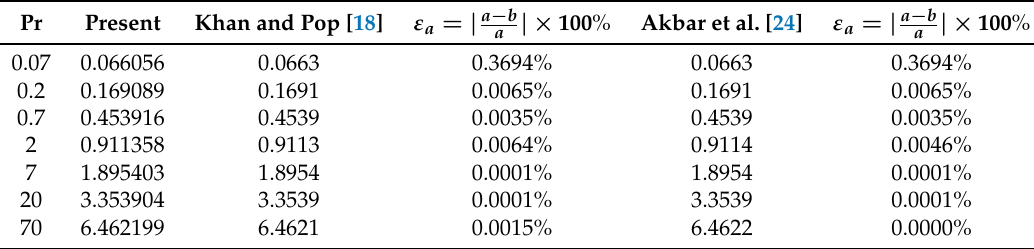
Table 1. Comparison data of − θ (cid:48) ( 0 ) for the case of unstratified viscous fluid when M = λ = N = Nb = Nt = γ T = 0, ε = 1 and various values of